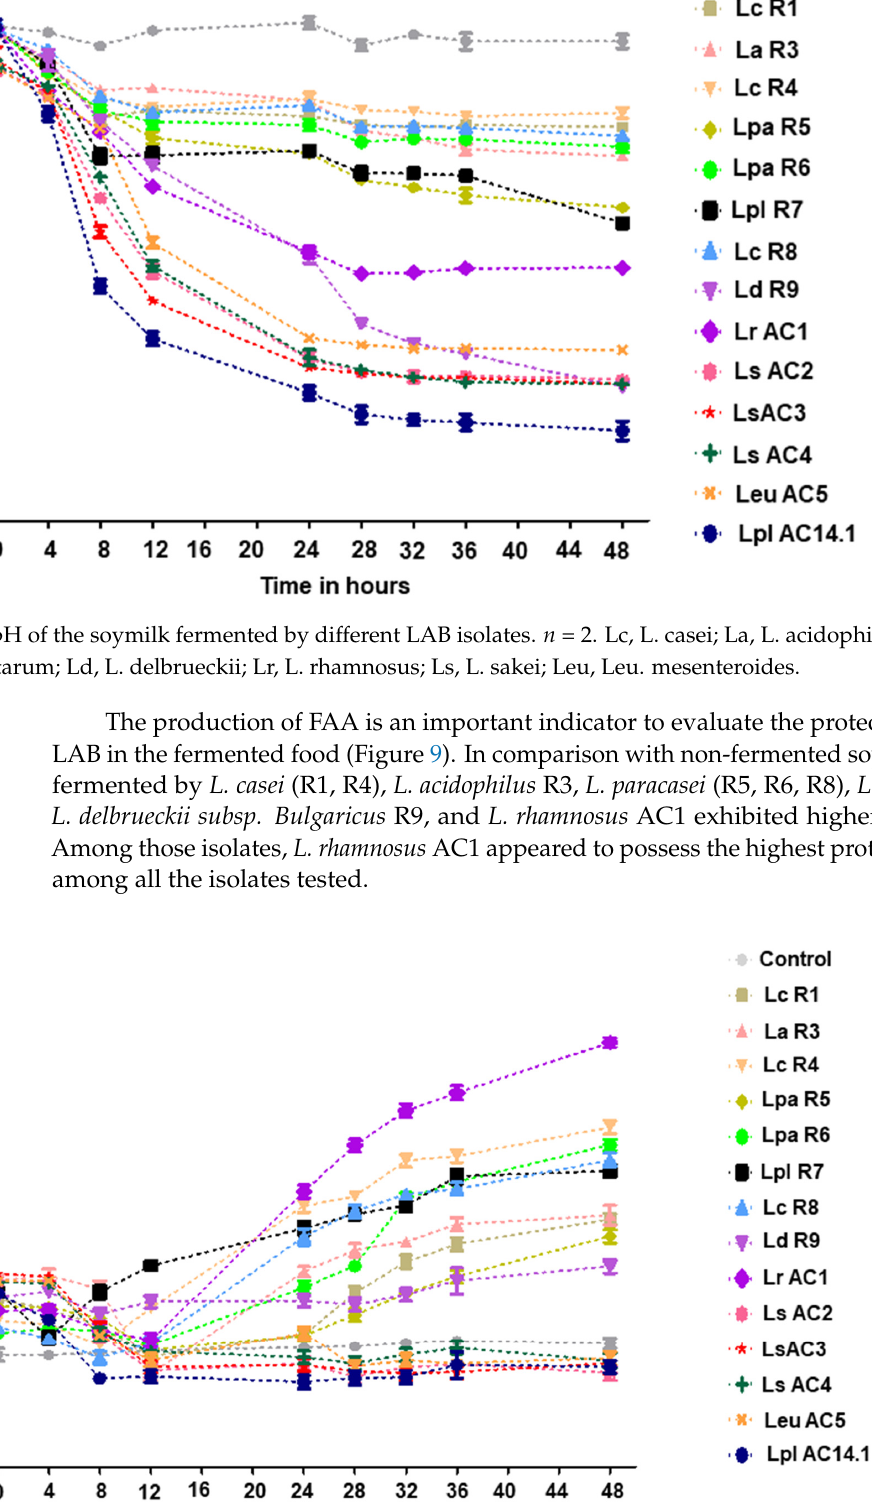
746.00 ± 9.90 b ND: not detectable. Different letters in the same column represent statistically significant results. The results were compared by one-way ANOVA and Turkey post hoc test within columns; p < 0.05; n = 2. Lc, L. casei; La , L. acidophilus; Lpa , L. paracasei; Lpl , L. plantarum; Ld , L. delbrueckii; Lr , L. rhamnosus; Ls , L. sakei; Leu , Leu. mesenteroides. To further confirm the changes of main isoflavone forms during the fermentation process of soymilk by L. rhamnosus AC1, six major isoflavone forms were measured in the